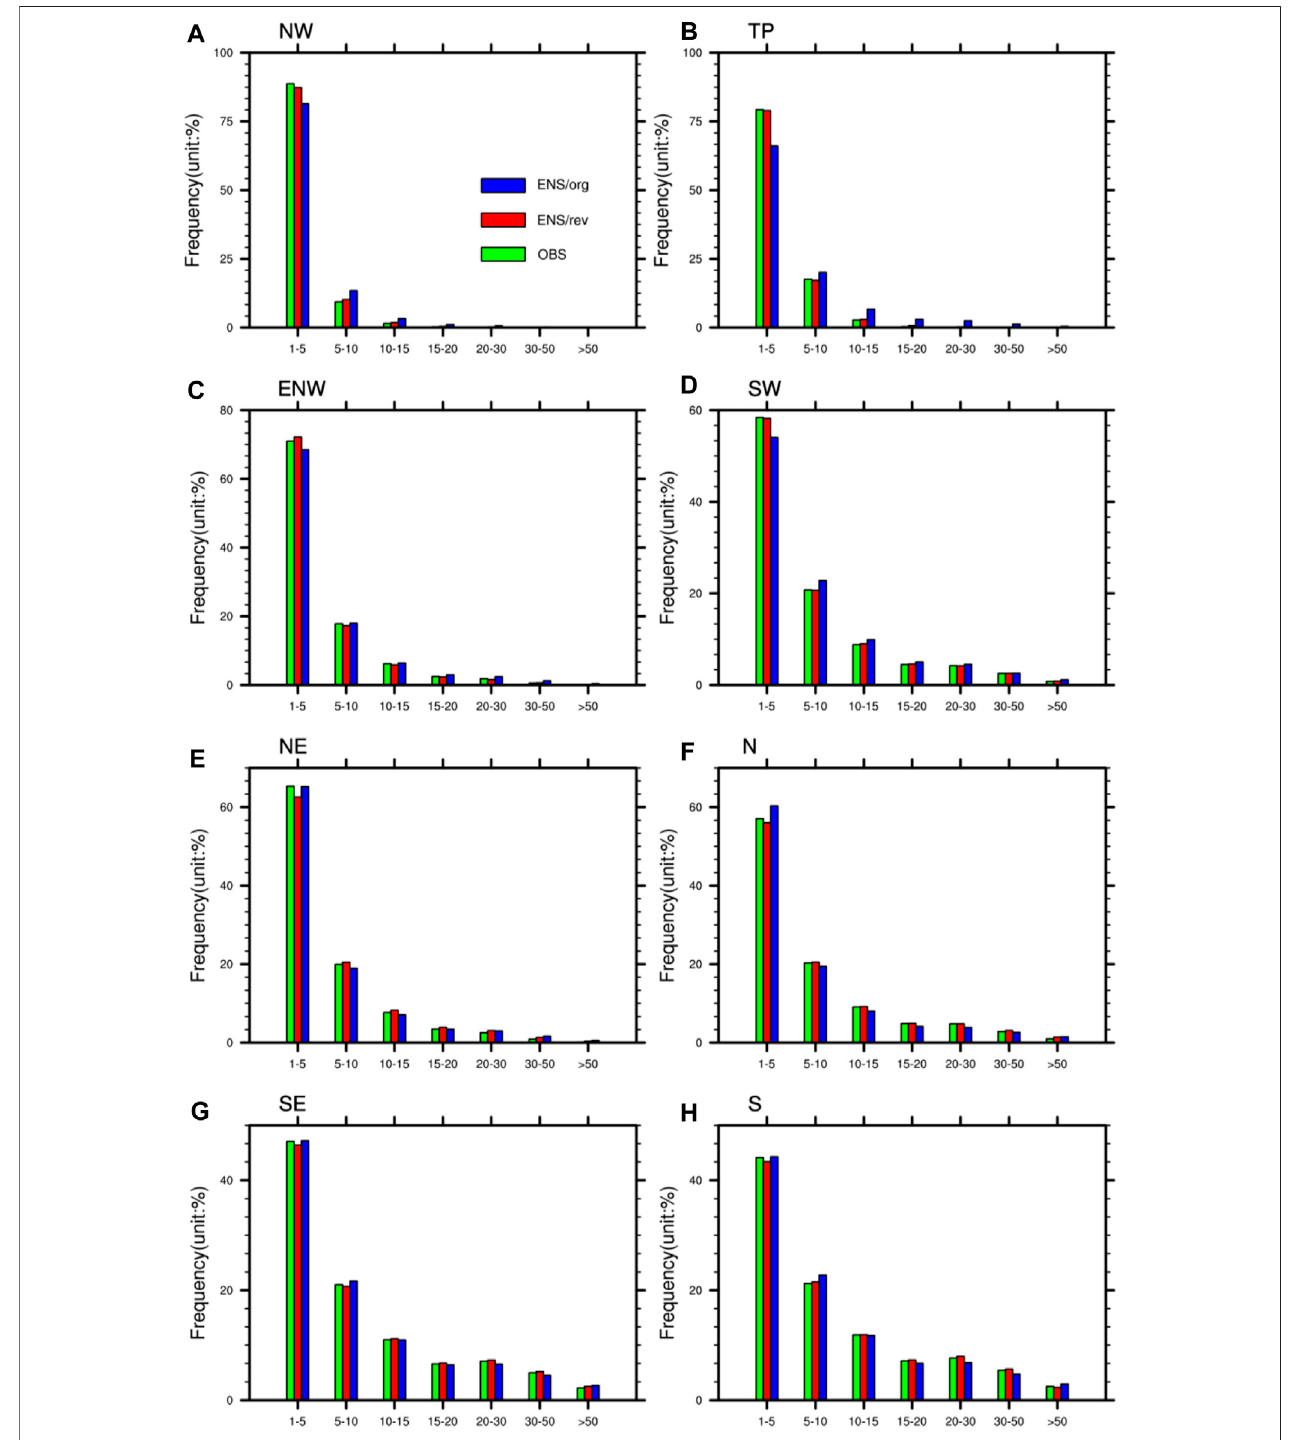
FIGURE 3 | Precipitation probability distributions ofthe observations and simulations in eight sub-regions ofChina before and after correction (A – H) . Blue and red columns represent the simulations before and after correction, respectively. Green columns indicate the observed values.